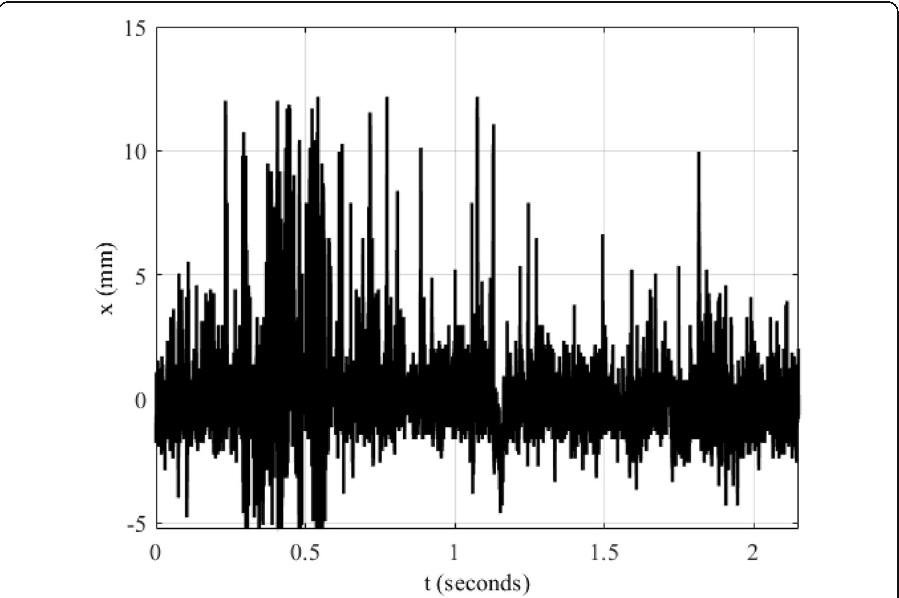
Fig. 10 Normal shock wave location (with respect to the time-averaged shock wave position) as a function of time for vertical pixel number 277 for data acquired on 05 April